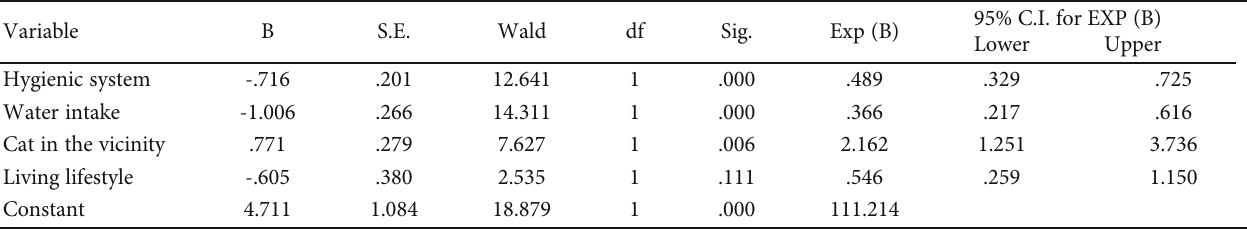
Table 4: Associated possible risk factors with IgM antibody of Toxoplasma gondii prevalence in ruminants using binary logistic model. Variable B